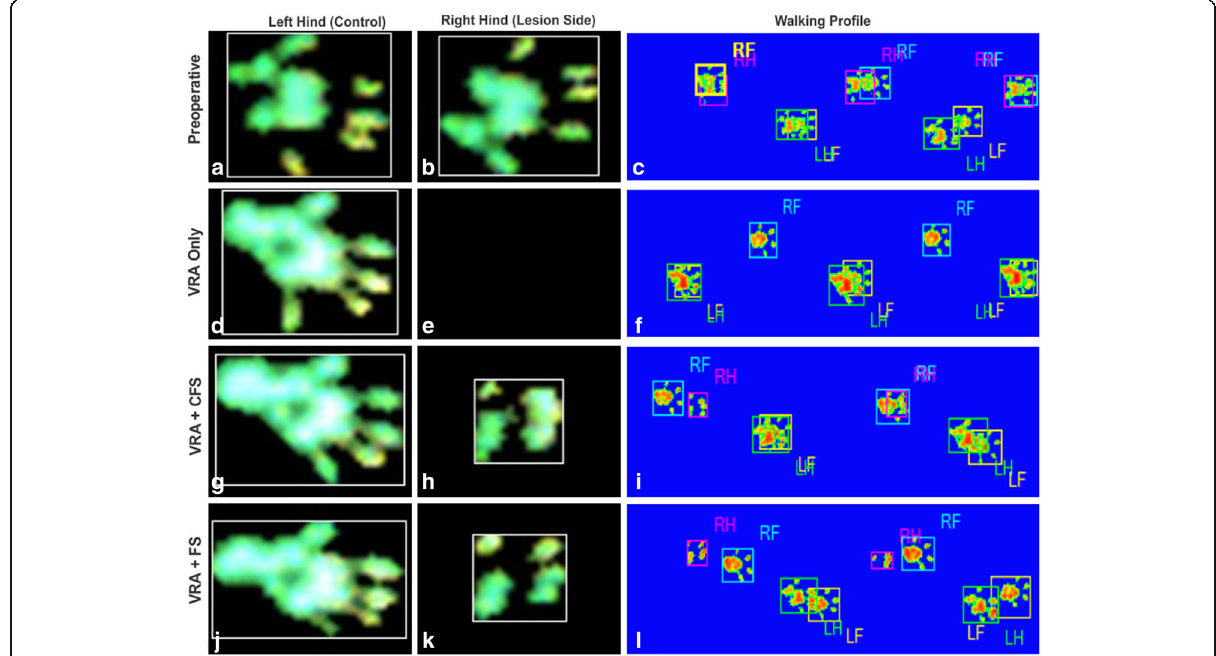
Fig. 2 Paw prints and walking profile after ventral root avulsion and treatment with two different fibrin sealants, obtained with the CatWalk System (Noldus®). a - c Preoperative; d - f ventral root avulsion (VRA) only; g - i VRA followed by reimplantation with new heterologous fibrin sealant derived from snake venom (VRA+HFS); j - l VRA followed by reimplantation with commercial fibrin sealant (VRA+FS). It is possible to observe that ( h and k )